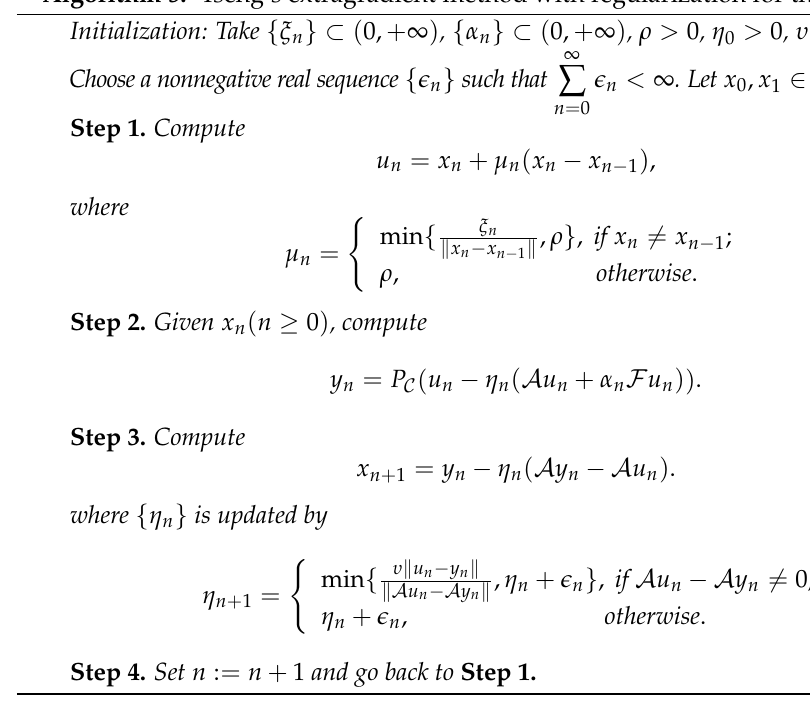
Algorithm 5: Tseng’s extragradient method with regularization for the